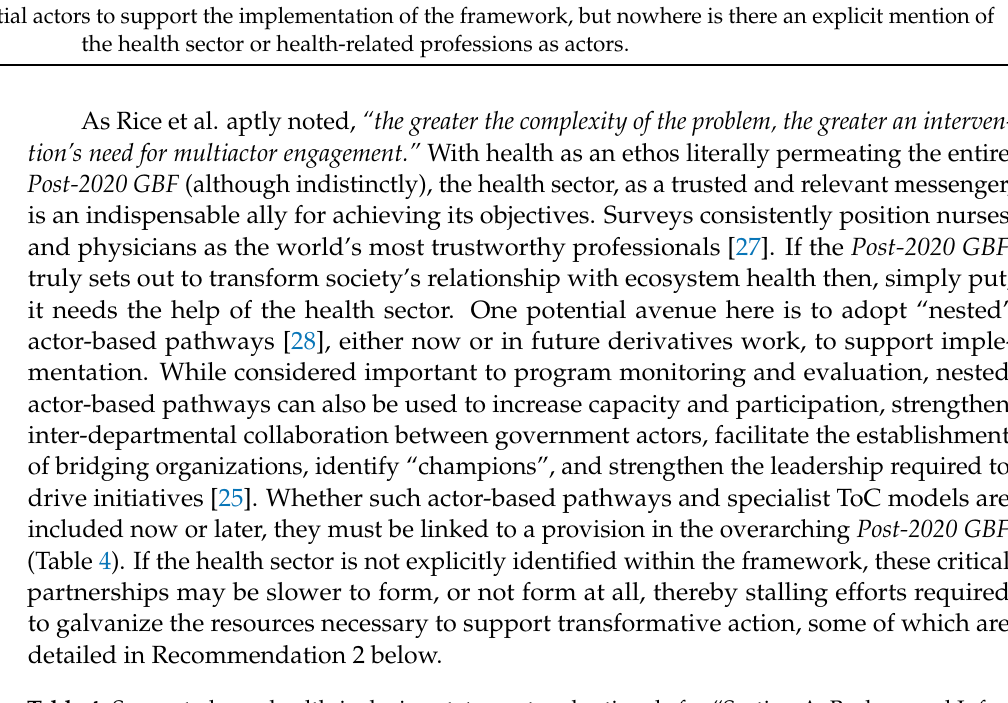
Table 4. Suggested new health-inclusion statement and rationale for “Section A. Background